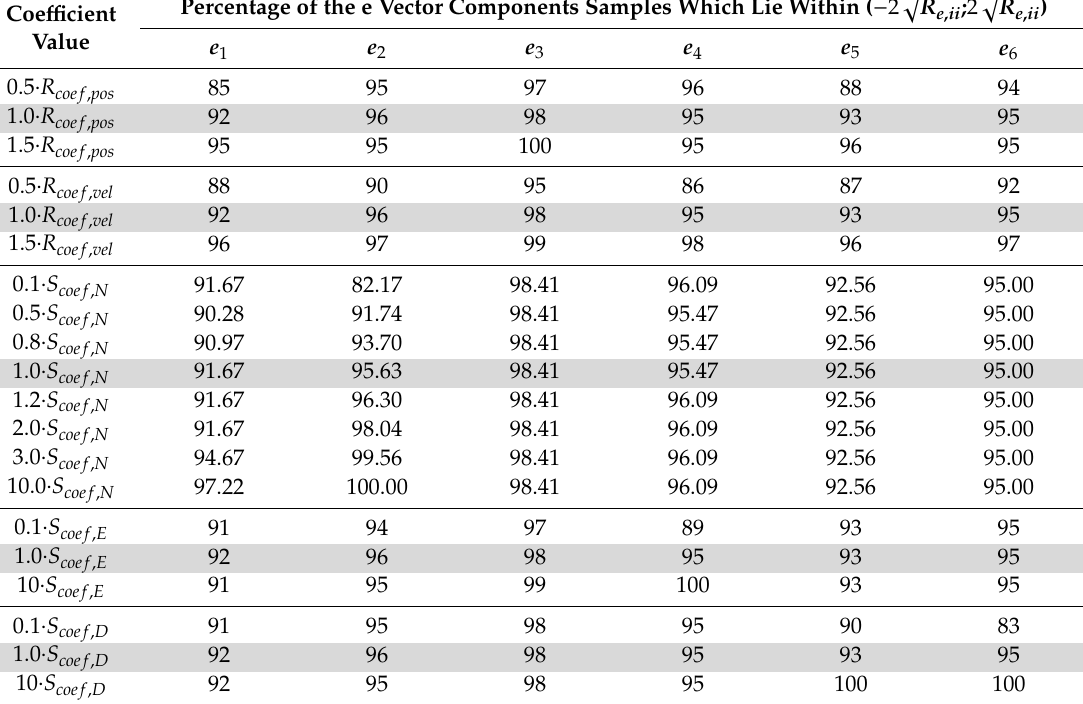
Table 2. Influence of the tuned parameters on the e vector statistical